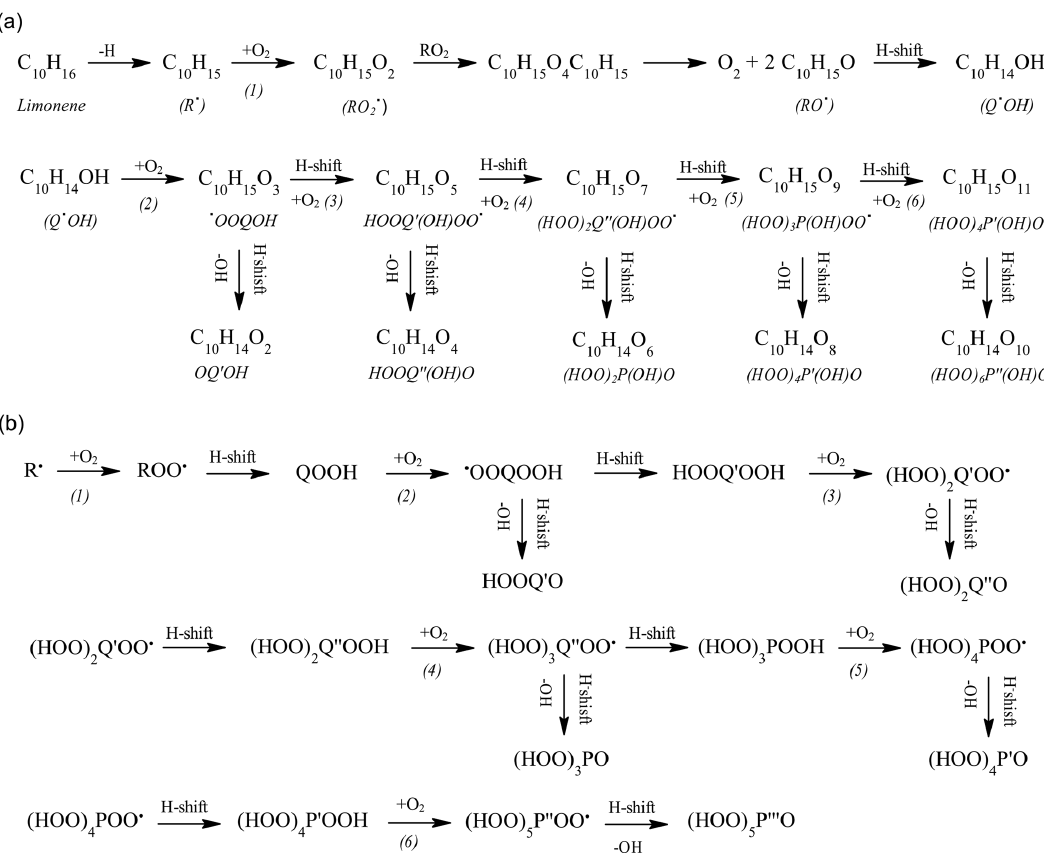
Figure 7. Reaction pathways to highly oxygenated products considered in atmospheric chemistry (a, b) (Bianchi et al., 2019). Recently extended reaction pathways in combustion (b) (Z. Wang et al., 2017).